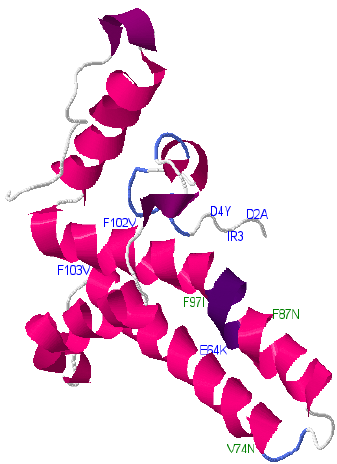
Figure 3. Mutations within the core region of subgenotype